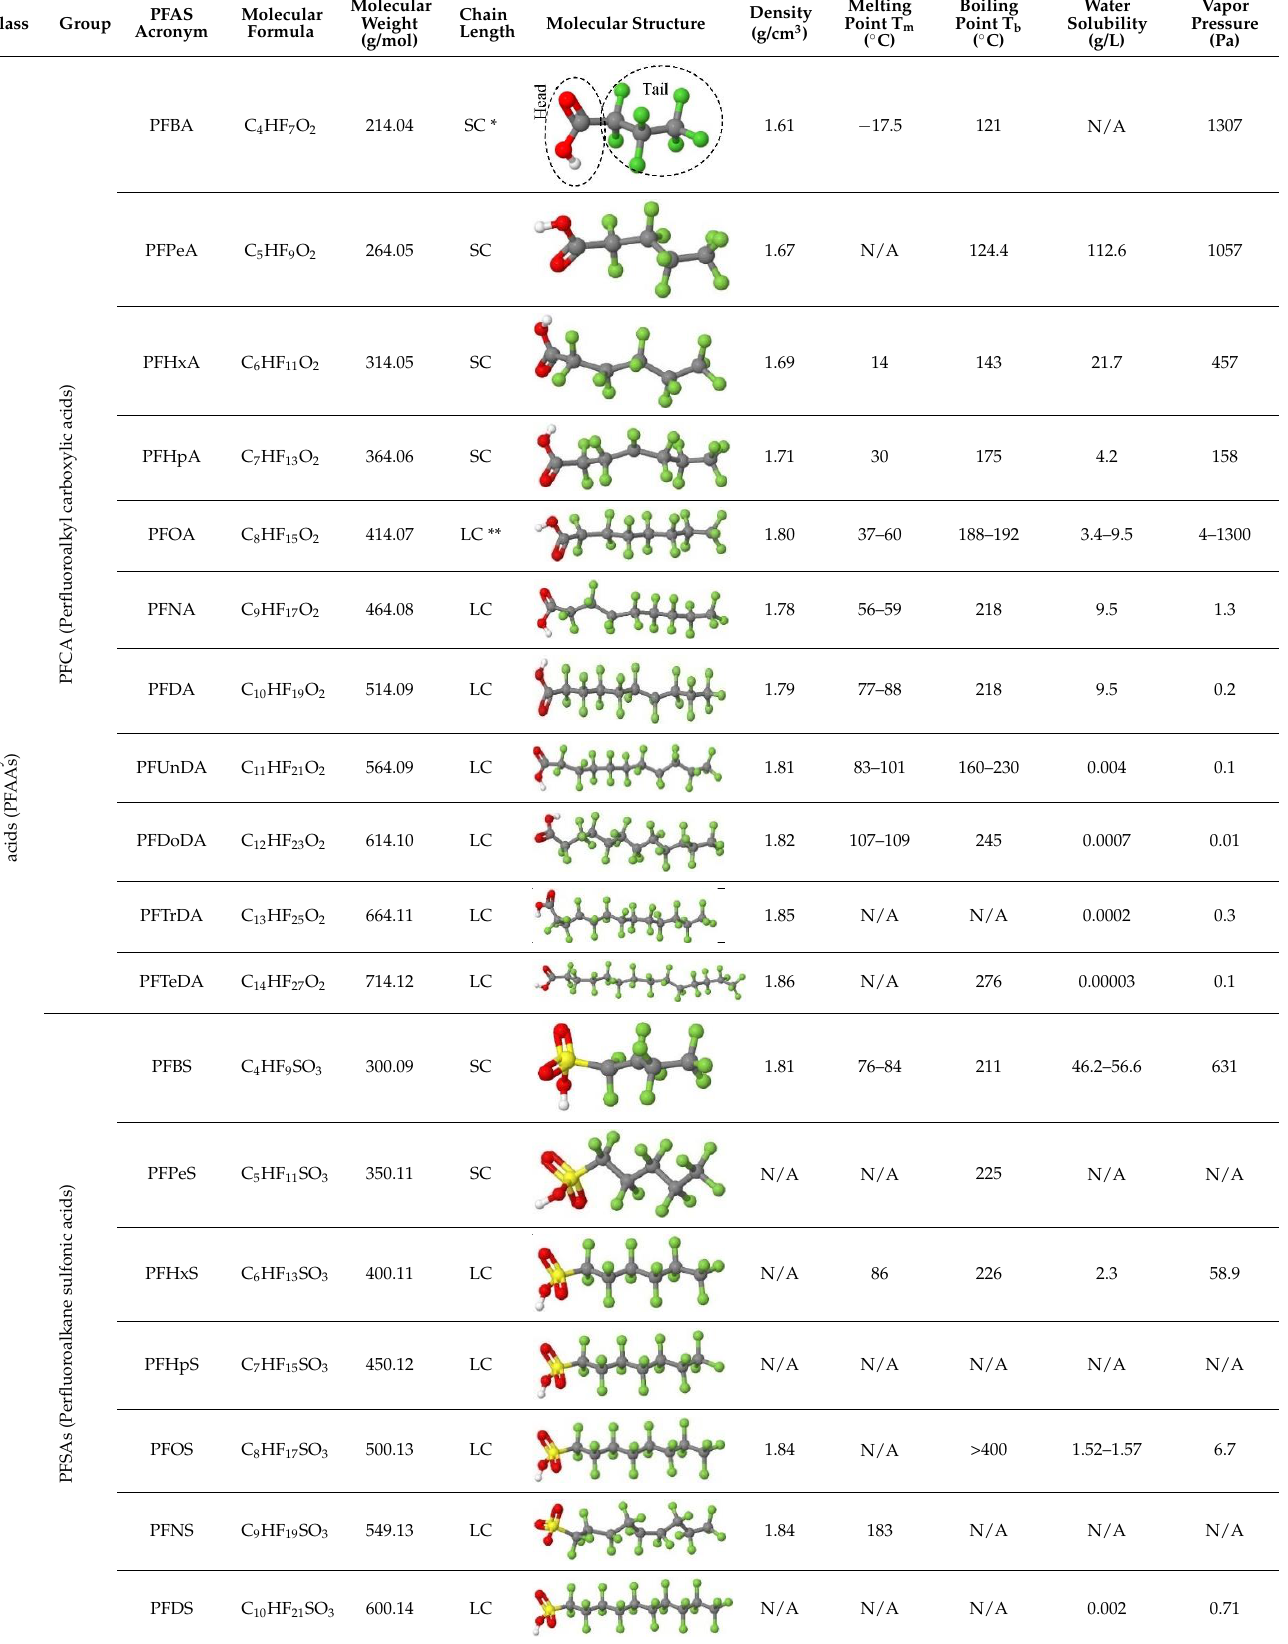
Table 2. Characteristics of detected PFASs.